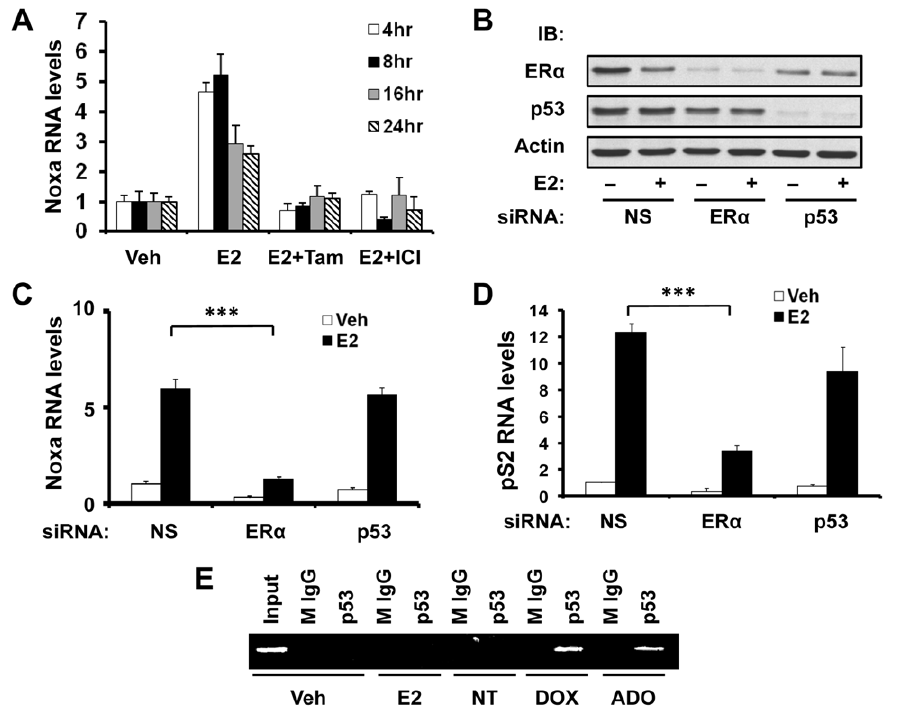
Figure 2. E2-induced Noxa transcription is ER a -dependent and p53-independent. ( A ) MCF7 cells were treated with vehicle (veh), 10 nM E2 alone, 10 nM E2 in combination with 1 m M tamoxifen (Tam), or 10 nM E2 in combination with 1 m M ICI 182780 (ICI) for various times. Four, 8, 16 and 24 hr after treatment, cells were harvested, and Noxa mRNA expression levels were analyzed by qPCR. ( B, C, & D ) MCF7 cells were transfected with non-silencing control (NS), ER a , or p53 siRNA for 24 hr, followed by treatment with vehicle (veh) or E2 (10 nM) for 8 hr, and then harvested for analyses of ER a , p53, and b -actin (internal control) protein expression by western blotting (B), Noxa mRNA expression by qPCR (C), and pS2 mRNA expression by qPCR (D). ( E ) MCF7 cells were treated with vehicle (veh), E2 (10 nM), doxorubicin (DOX; 1.70 m M), adozelesin (ADO; 4 nM), or left without treatment (NT) for 16 hr. Occupancy of p53 on the proximal region of the NOXA promoter was determined by ChIP assays, using anti-p53 antibody or normal mouse IgG (M IgG; control antibody) for immunoprecipitation. Graphical data points in A, C, and D are means 6 S.D. of three independent experiments (*** P , 0.001).